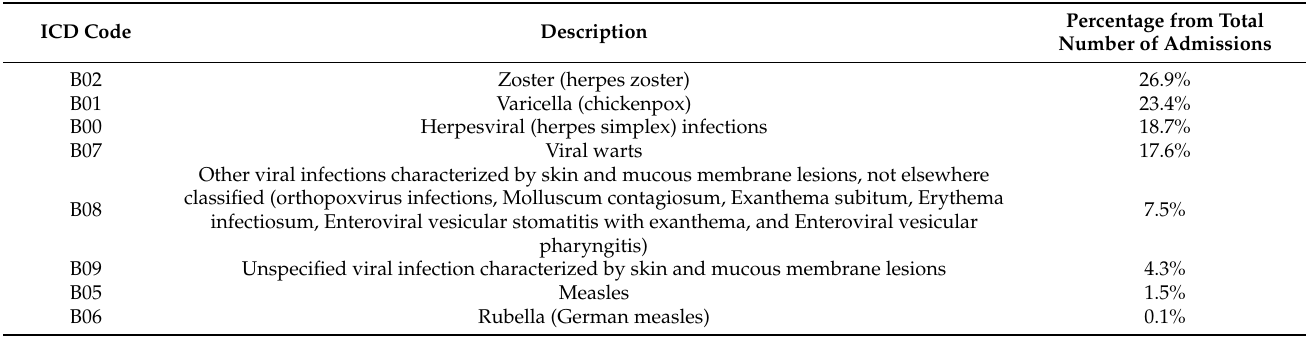
Table 1. Percentage of viral infections characterized by skin and mucous membrane lesions hospital admission from total number of admissions per ICD code during the study